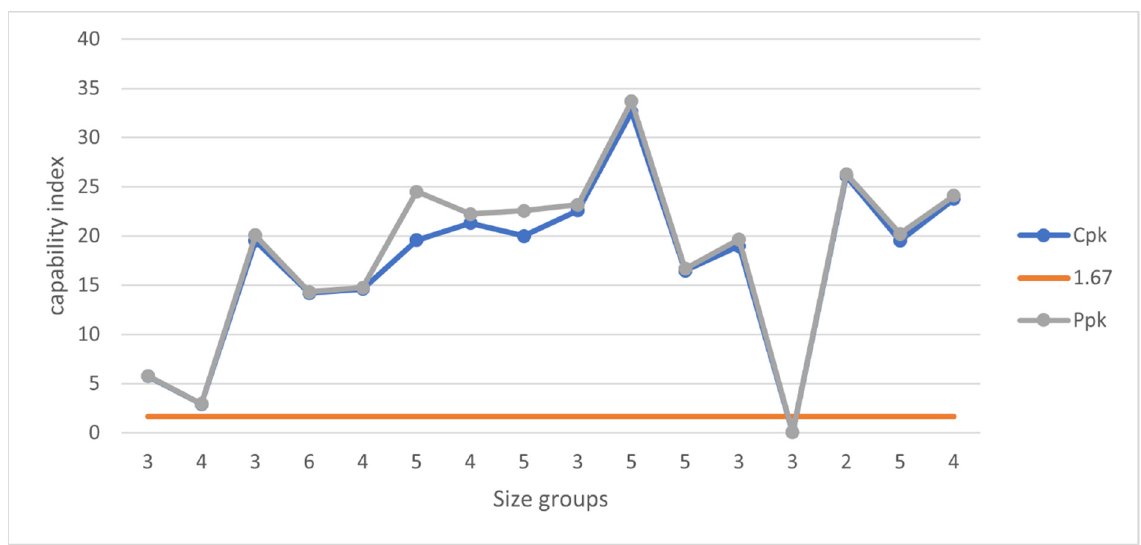
Figure 15. Plot of capability index for all DIMs based on sizes.